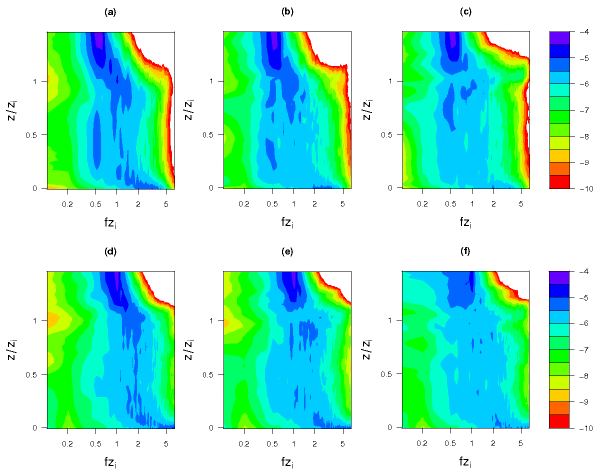
Fig. 7. (Top) Normalized spectra [P m] for the control simula- tion employing the observed (unfiltered) conditions. (a) Vertical velocity (b) air temperature (c) specific humidity and (bottom) nor- malized cospectra for (d) vertical velocity and air temperature (e) vertical velocity and specific humidity and (f) air temperature and specific humidity.